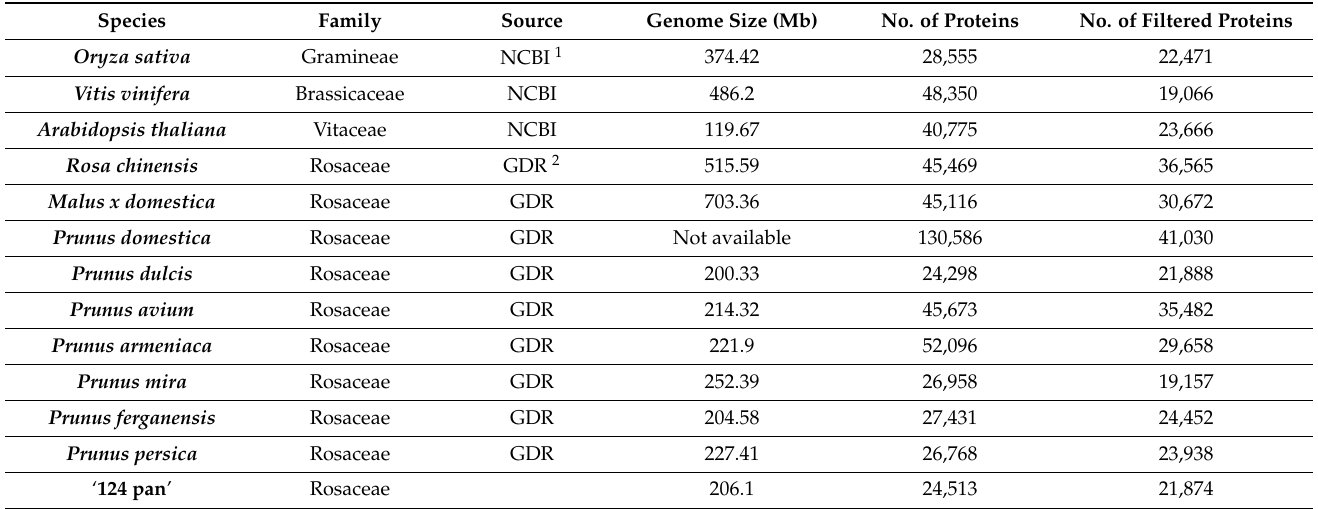
Table 4. Information of species used for phylogenetic analyses in this